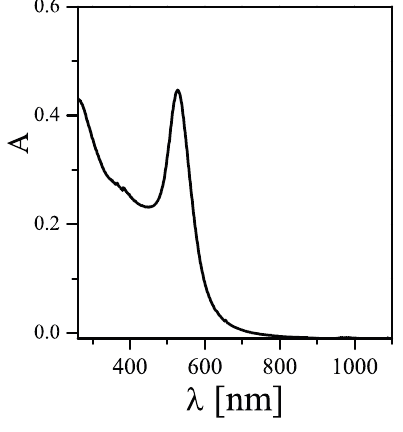
Figure 2. UV/Vis absorption spectrum A ( λ ) of Au NPs dispersed in water, directly recorded after their synthesis as described in this